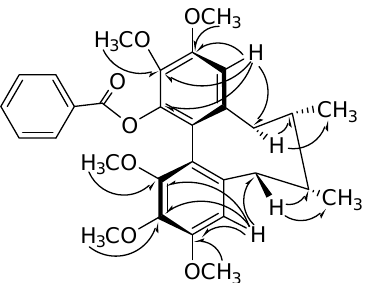
Figure 4 . Key HMBC and NOESY Correlations of compound 2.